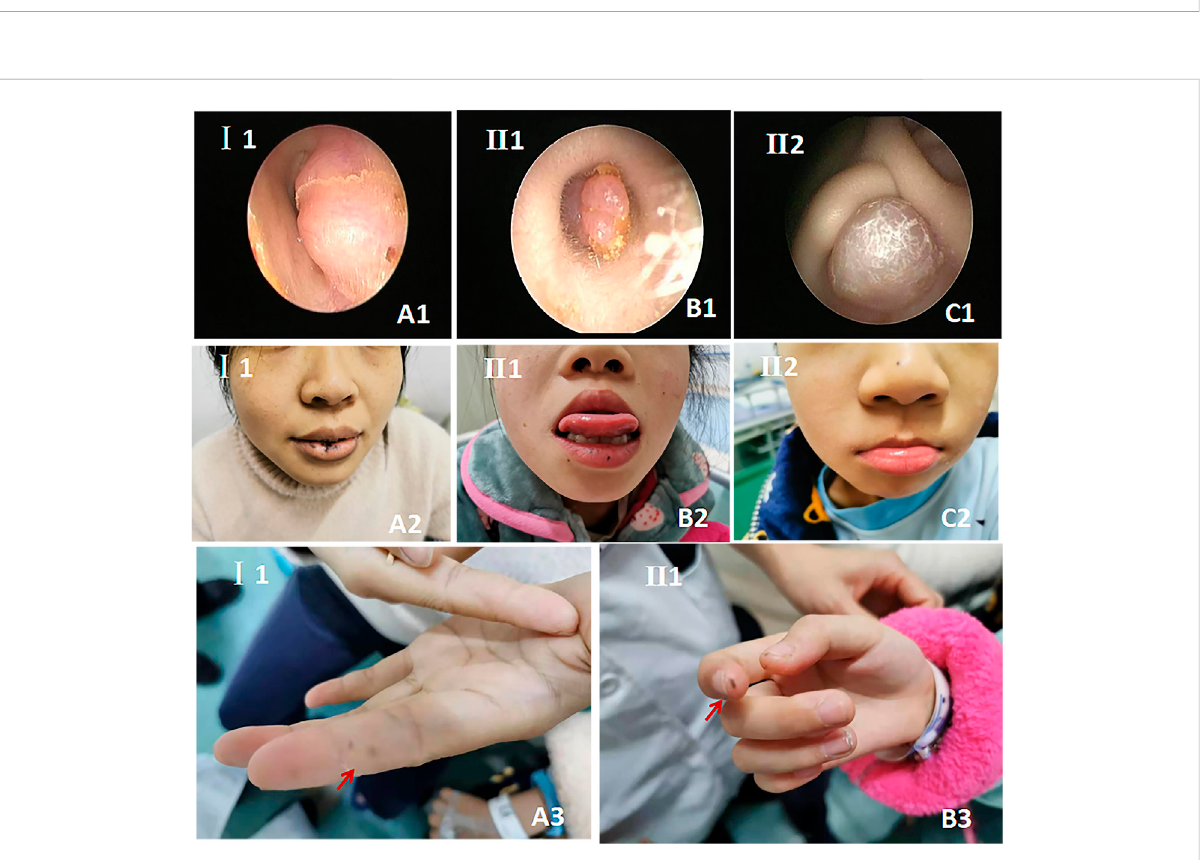
FIGURE 1 Family pedigree. Males and females are denoted by squares and circles, respectively. The arrow denotes the proband, fi lled symbols denote Carney complex (CNC) patients, and un fi lled symbols denote unaffected individuals. Symbols with horizontal lines denote individuals with spotty pigmentation, symbols with vertical lines denote those with external auditory canal myxomas, and symbols fi lled with horizontal and vertical lines denote those with both